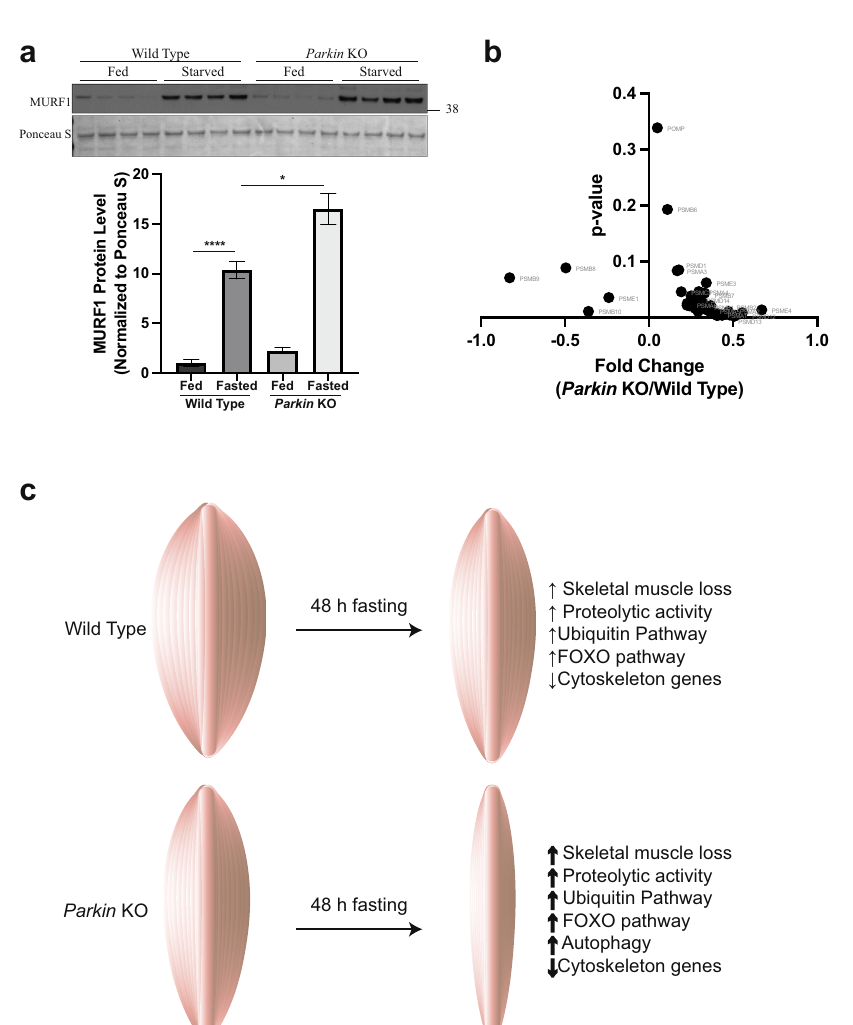
Fig. 5 Parkin de fi ciency increases fasting-induced muscle mass loss. a Top, Representative images of western blot analysis of MURF1 in wild type and Parkin KO gas muscle. The levels of Ponceau S were assessed as a loading control ( n = 4). Bottom , Graph showing quanti fi cation of MURF1 protein levels, normalized to Ponceau S, in arbitrary units ( n = 4). b Volcano plot showing proteasome genes obtained from GSEA KEGG_Proteasome gene set and their expression levels (log2) in fasted Parkin KO mice as compared to fasted wild type mice with p -value on the y -axis ( n = 4). c 48h fasting leads to muscle wasting in mice, which is further augmented in Parkin KO mice. Fasting-induced skeletal muscle wasting in Parkin KO mice is regulated through increased expression of genes associated with FOXO, ubiquitin pathway and autophagy, and decreased expression of cytoskeleton genes. Data represent mean±s.e.m. with error bars indicating s.e.m., * P < 0.05, **** P < 0.0001 (ordinary one-way reduced expression of cytoskeleton genes further suggests that active state for days 64 . This indicates that increased catabolic Parkin de fi ciency sensitises skeletal muscle to fasting-induced activities perpetuate in skeletal muscle during fasting. Here, wasting. Moreover, expressions of several critical autophagy genes microarray analyses revealed that ubiquitin and FOXO pathway are regulated under the control of FOXO transcription factors 56,65 . genes that are increased upon fasting are further increased in skeletal muscle of Parkin KO mice, underscoring the role of Especially, FOXO3 has been shown to be required for the hypercatabolism in skeletal muscle upon loss of Parkin . In addition, induction of starvation-induced autophagy. However, atrogenes